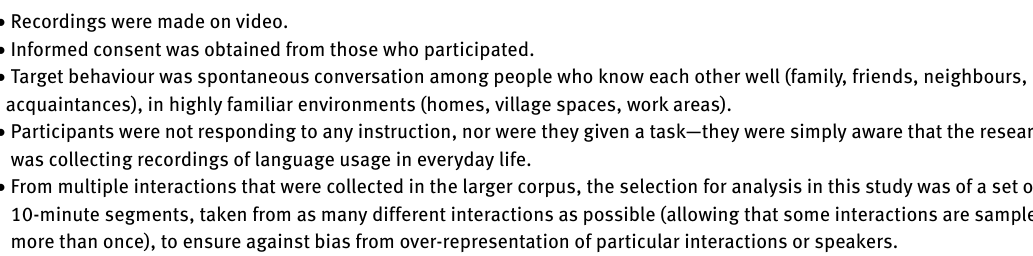
Table 1: Key properties of the data collected for the studies in this